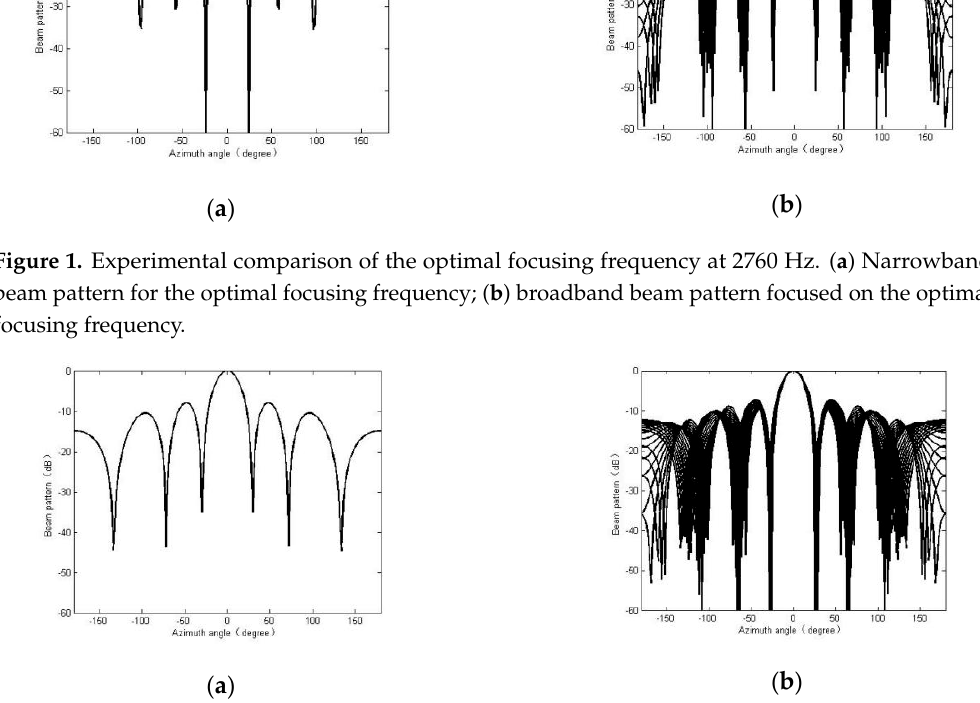
Figure 2. Experimental comparison of focusing frequency at 2250 Hz. ( a ) Narrowband beam pattern at 2250 Hz; ( b ) broadband beam pattern focused on the focusing frequency of 2250 Hz.